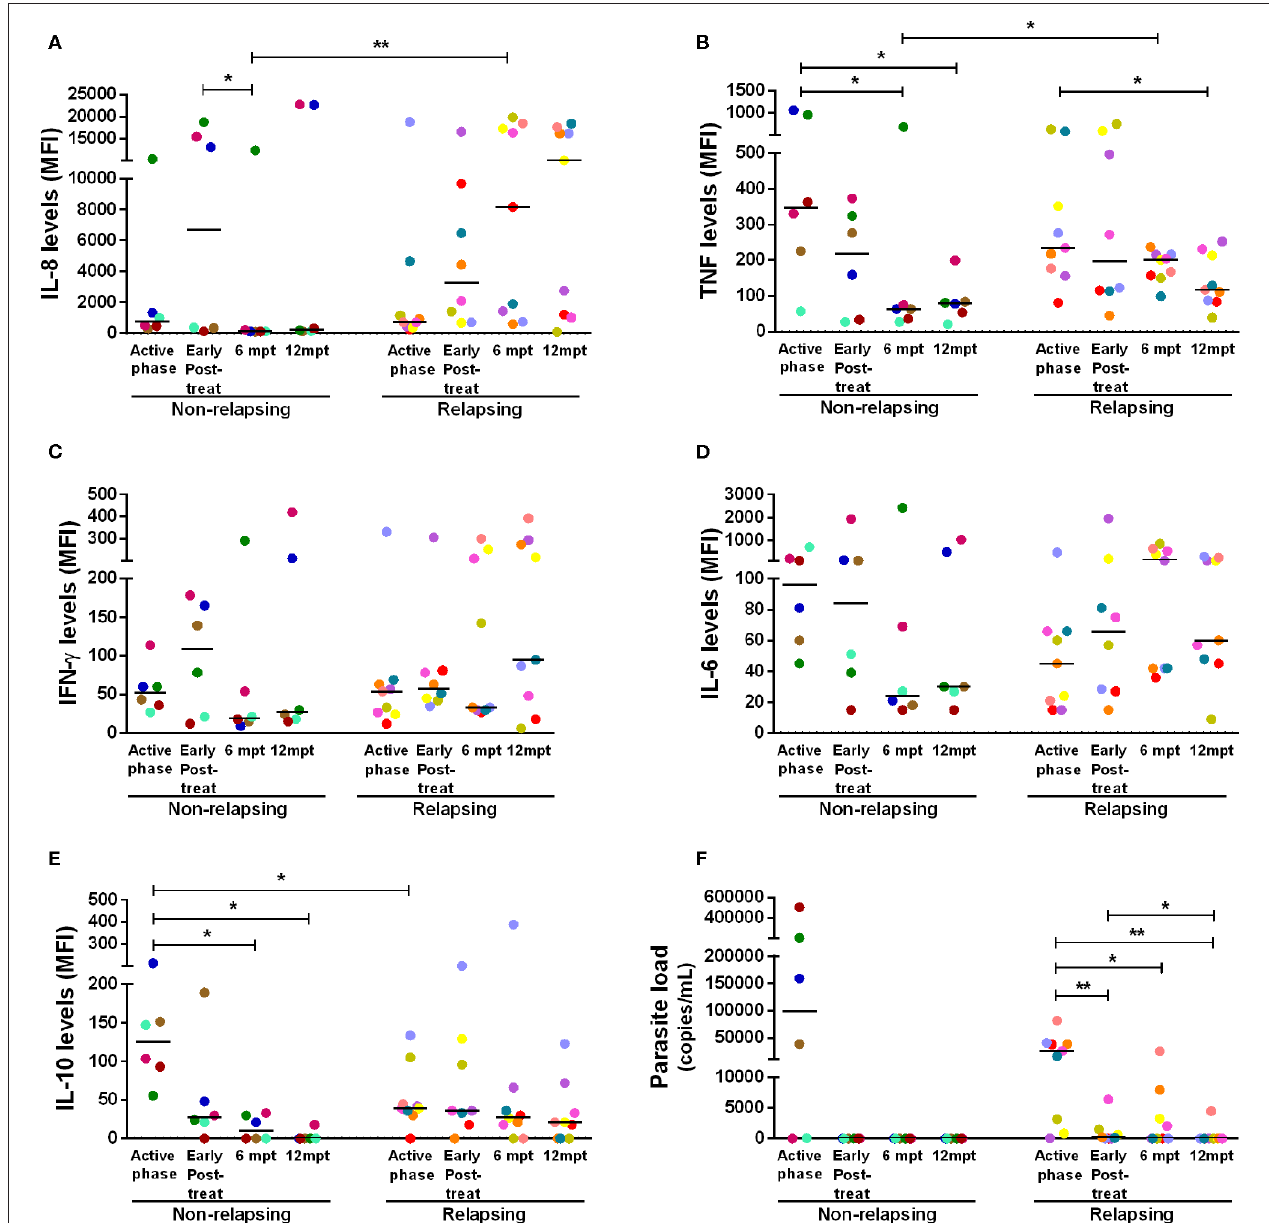
FIGURE 4 | Anti- and pro-inflammatory cytokines levels and parasite load of the non-relapsing and relapsing-visceral leishmaniasis/HIV (VL/HIV) co-infected patients during clinical follow-up. Plasma cytokine levels of IL-8 (A) , TNF (B) , IFN- γ (C), IL-6 (D) , IL-10 (E) and the parasite load (F) in NR-VL/HIV and R-VL/HIV co-infected patients in the active phase, early post-treatment, 6 and 12 mpt. The cytokines results were represented in Median Fluorescence Intensity (MFI). The cytokine levels were assessed by Luminex assay and the parasite load quantification by qPCR. Each point represents a VL/HIV co-infected patient and each color represents the same patient in the different phases of the follow-up. The horizontal bar represents the median values. Early Post-treat (early post-treatment); 6 mpt (6 months post-treatment); 12 mpt (12 months post-treatment). * p < 0.05 ** p <